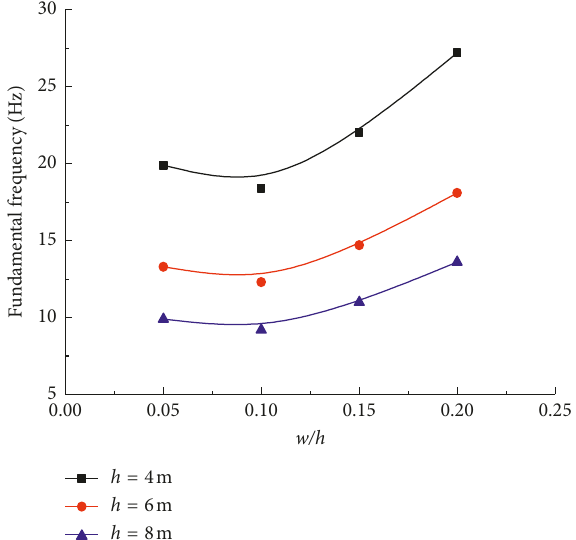
Figure 5: Effects of cross section shape on fundamental